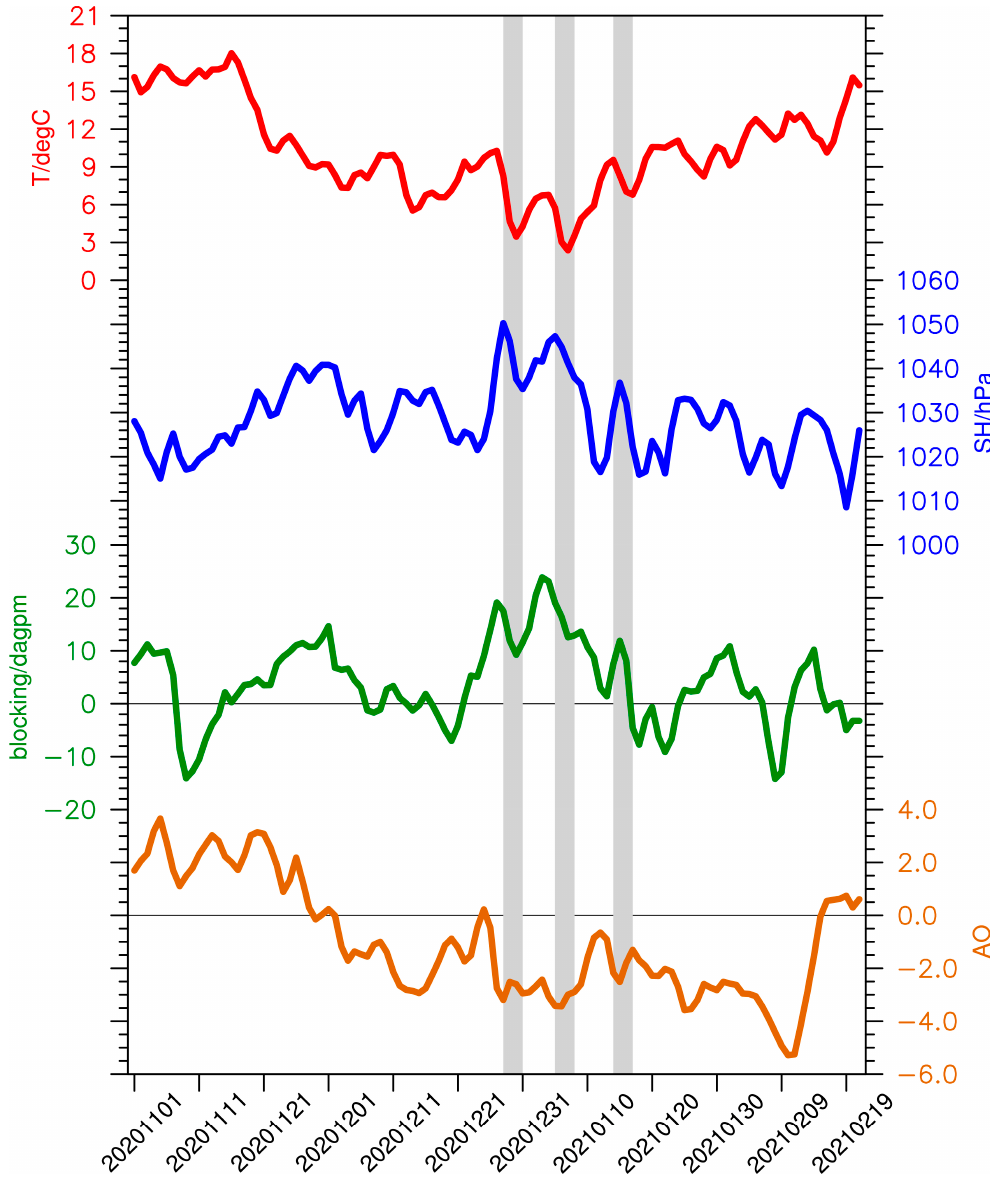
Figure 5. The time series of the Arctic Oscillation (AO) index at the bottom, the blocking high intensity index in the middle and lower sections, the Siberian high (SH) index in the middle and upper sections, and the average temperature (T) in eastern China (14 ◦ N–45 ◦ N, 105 ◦ E–120 ◦ E) from November 2020 to February 2021. The gray fill in the figure indicates the occurrence times of the three cold wave events.